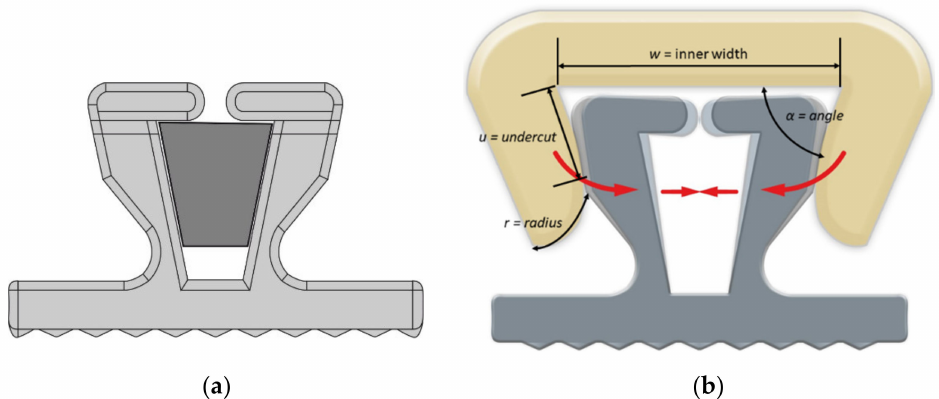
Figure 2. ( a ) In the superelastic NiTi bracket, the archwire is in contact with the wings, but does not touch the bottom. ( b ) Schematic drawing of the covering and its different design parameters. The covering compresses the wings to different degrees, depending on the inner width and design, allowing for better friction